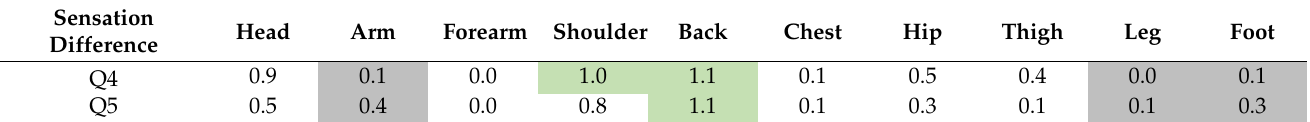
Table 8. Difference between thermal sensation level and neutral sensation level at Q4 and Q5 for the hot-sensitive people.